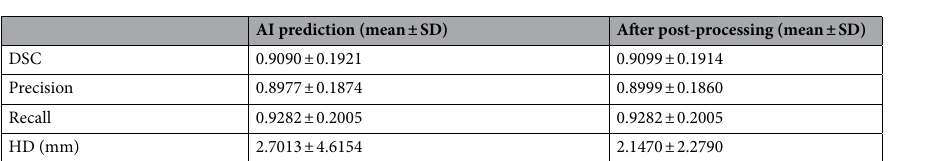
Table 2. Prediction results of AI prediction and after post-processing. AI artificial intelligence, DSC dice similarity coefficient, HD Hausdorff distance, SD standard